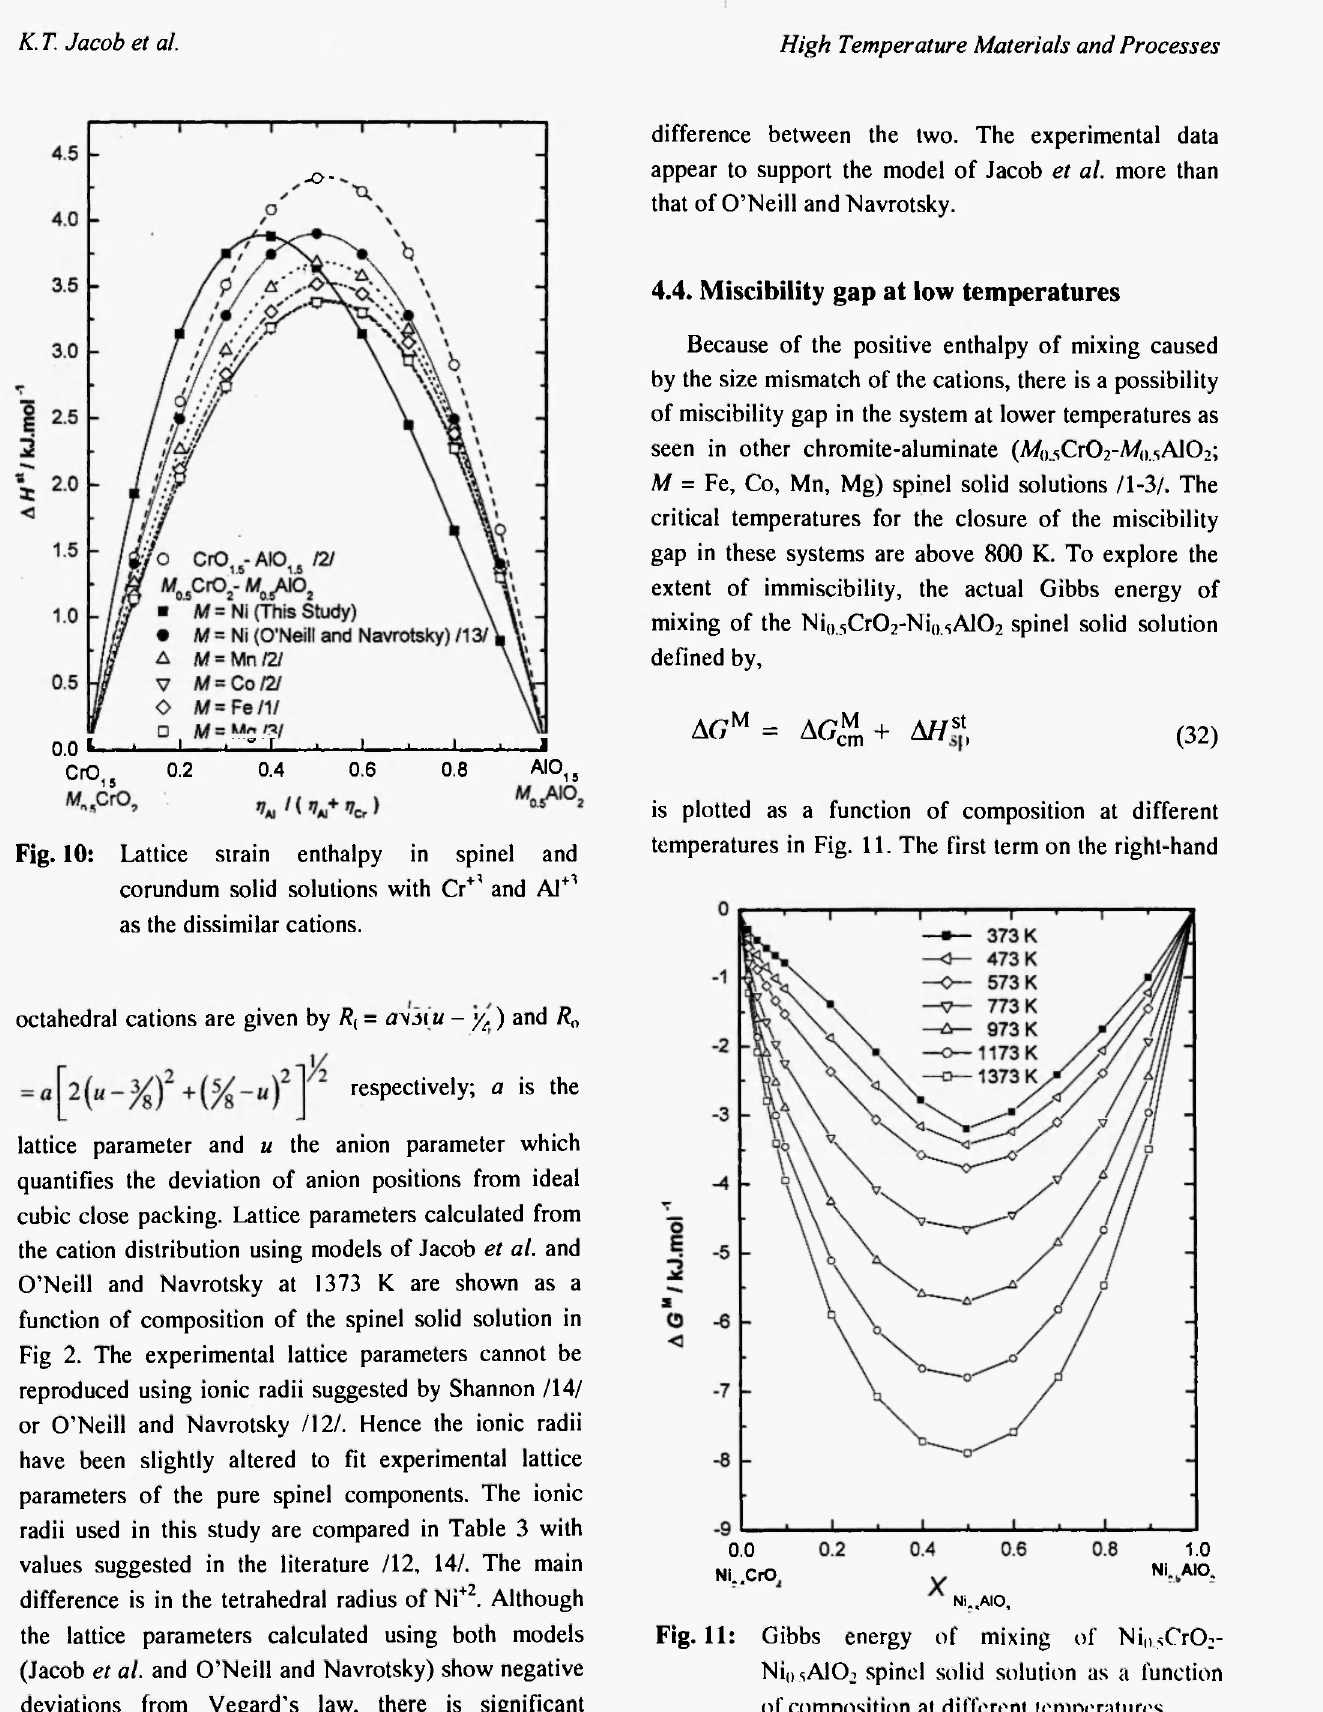
Fig. 11: Gibbs energy of mixing of Ni|, 5 CrO : - NiosAlO: spinel solid solution as a function of composition at different temperatures.